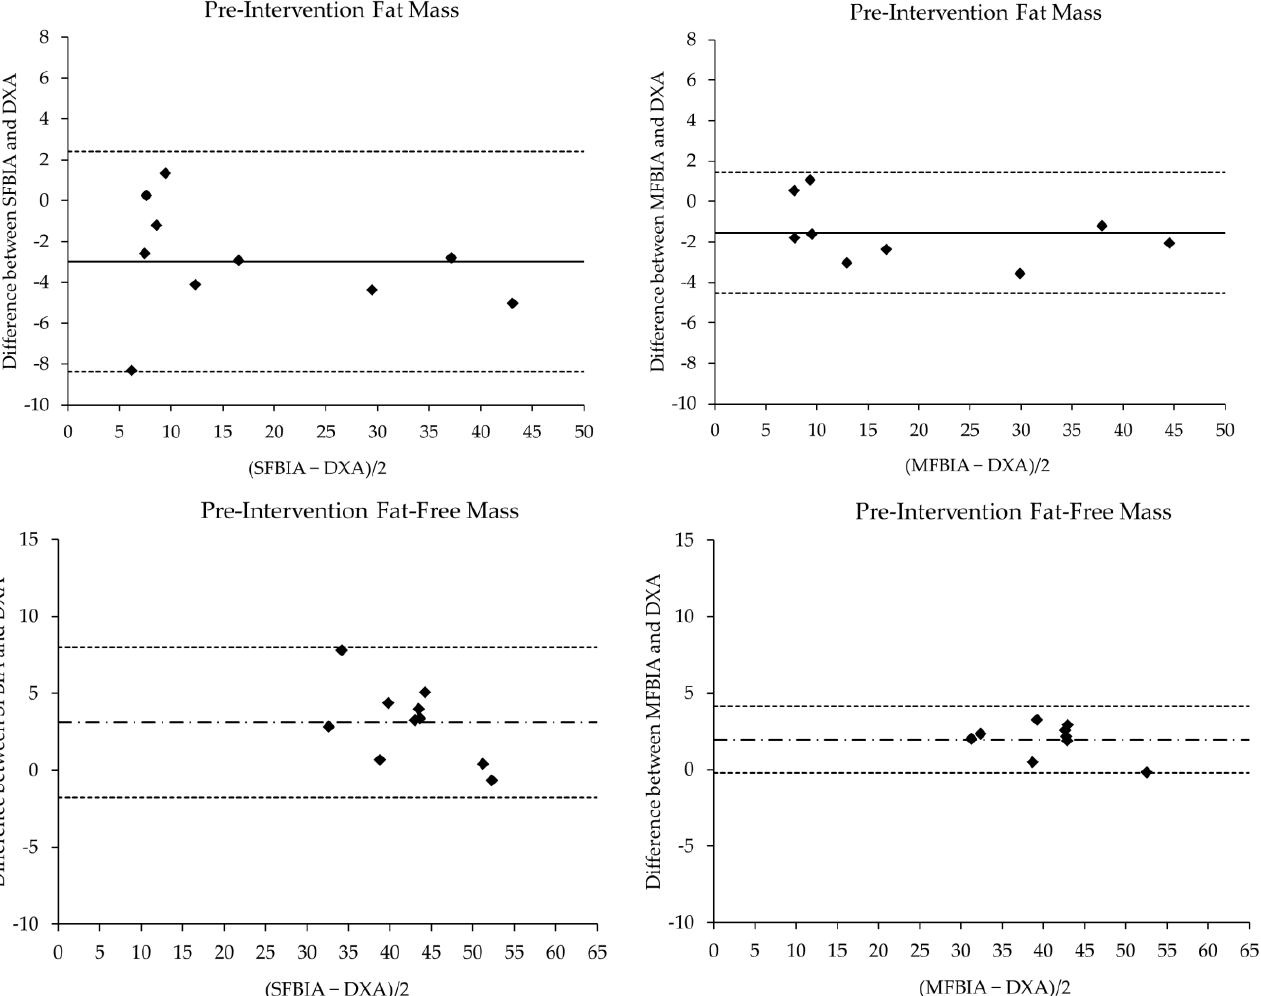
Figure 1. Bland-Altman plots comparing the pre-intervention body composition metrics acquired from single- and multiple-frequency bioelectrical impedance scales and dual energy X-ray absorp- tiometry. The solid lines represent the mean bias, whereas the outside dashed lines represent the 95% limits of agreement. The black circles represent each participants’ assessment values plotted between absolute difference between methods and mean difference. Fat mass and fat-free mass are expressed in kg. %Fat = percent body fat, DXA = dual energy X-ray absorptiometry, MFBIA = multiple-frequency bioelectrical impedance analysis, SFBIA = single-frequency bioelectrical impedance analysis.